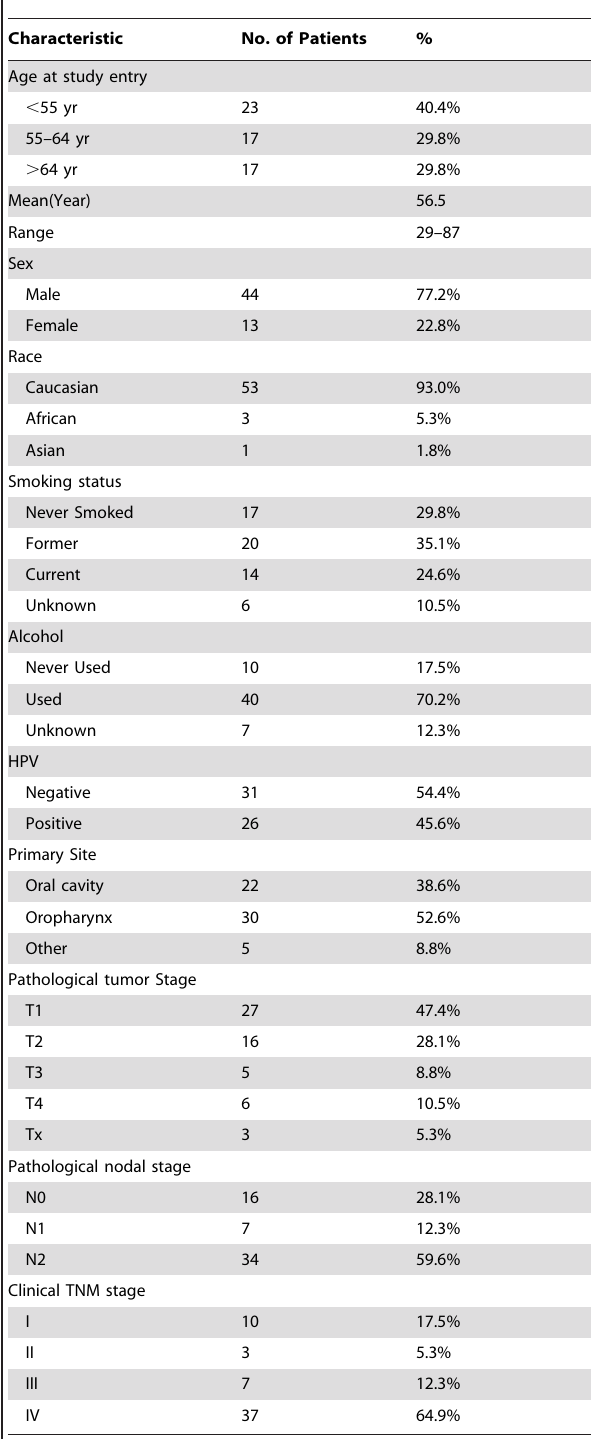
Table 1. Baseline Characteristics of the